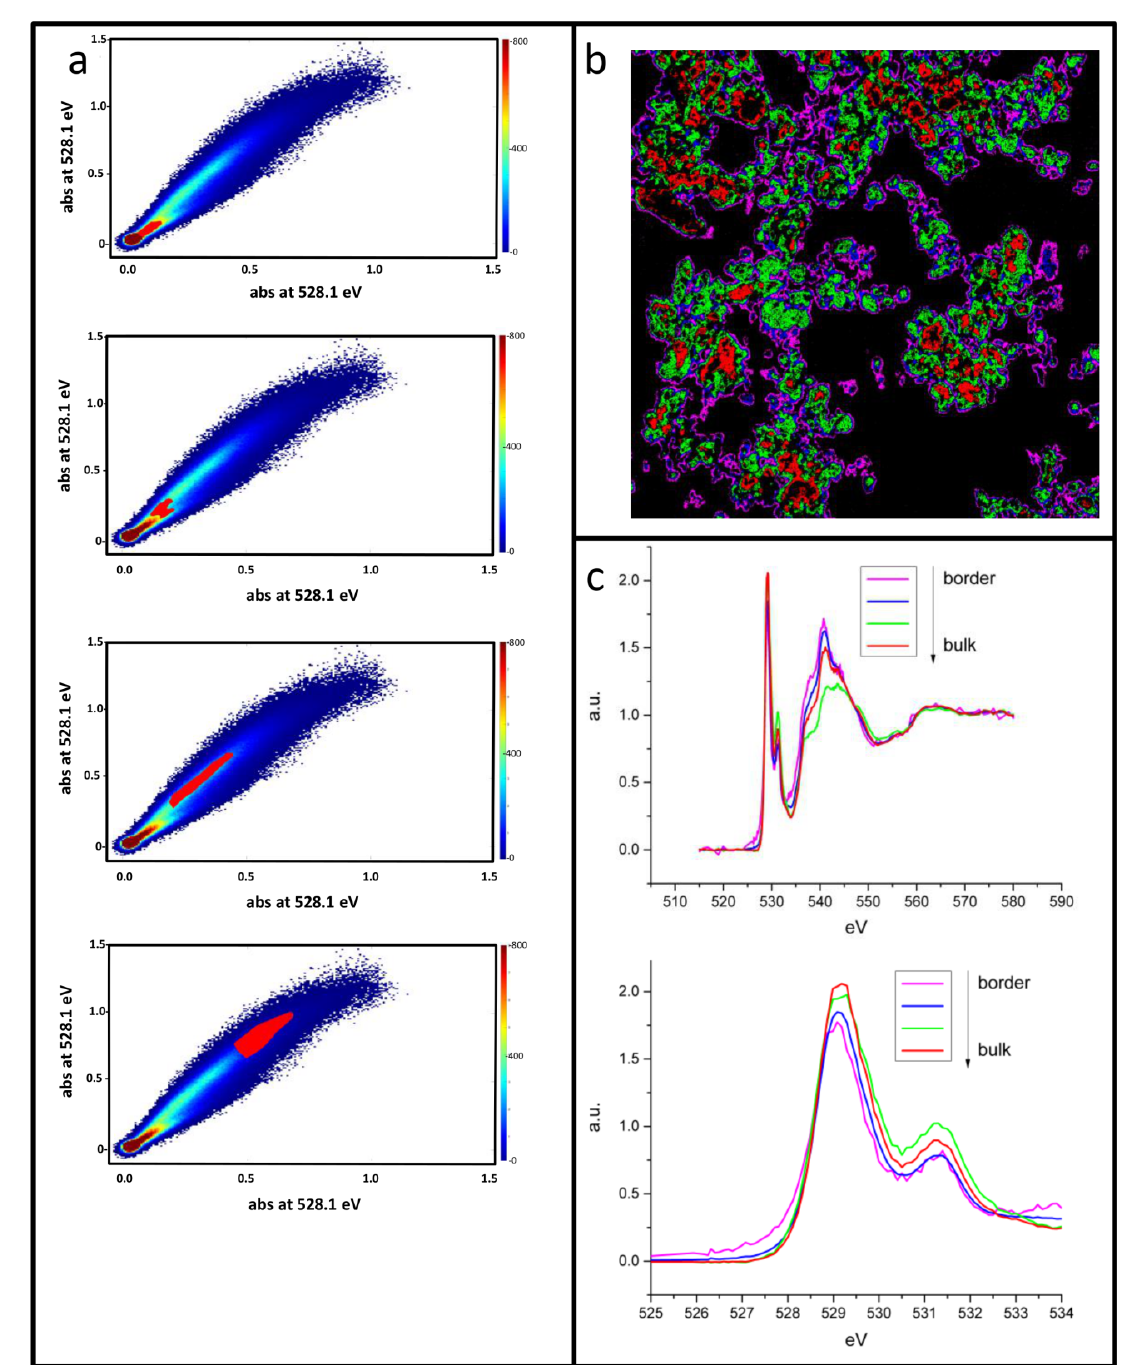
Figure 7. Data extracted at the O-K edge of the pristine Li 1.2 Mn 0.56 Ni 0.16 Co 0.08 O 2 electrode material (P01): ( a ) Scatter representation of ratio between main spectral components C and A (at 530.3 eV and 528.1 eV), each point representing a pixel with a specific ratio value. Because of the great number of pixels ( ≈ 10 6 ) the density of point is reported using different colors. Using the scatter plot, different ratios can be systematically selected in the field of view. Their spatial localization is then represented in ( b ), while in ( c ) the corresponding normalized spectra are reported, including a zoom on the prepeaks O-K edge region is shown with clear different peak intensities features.